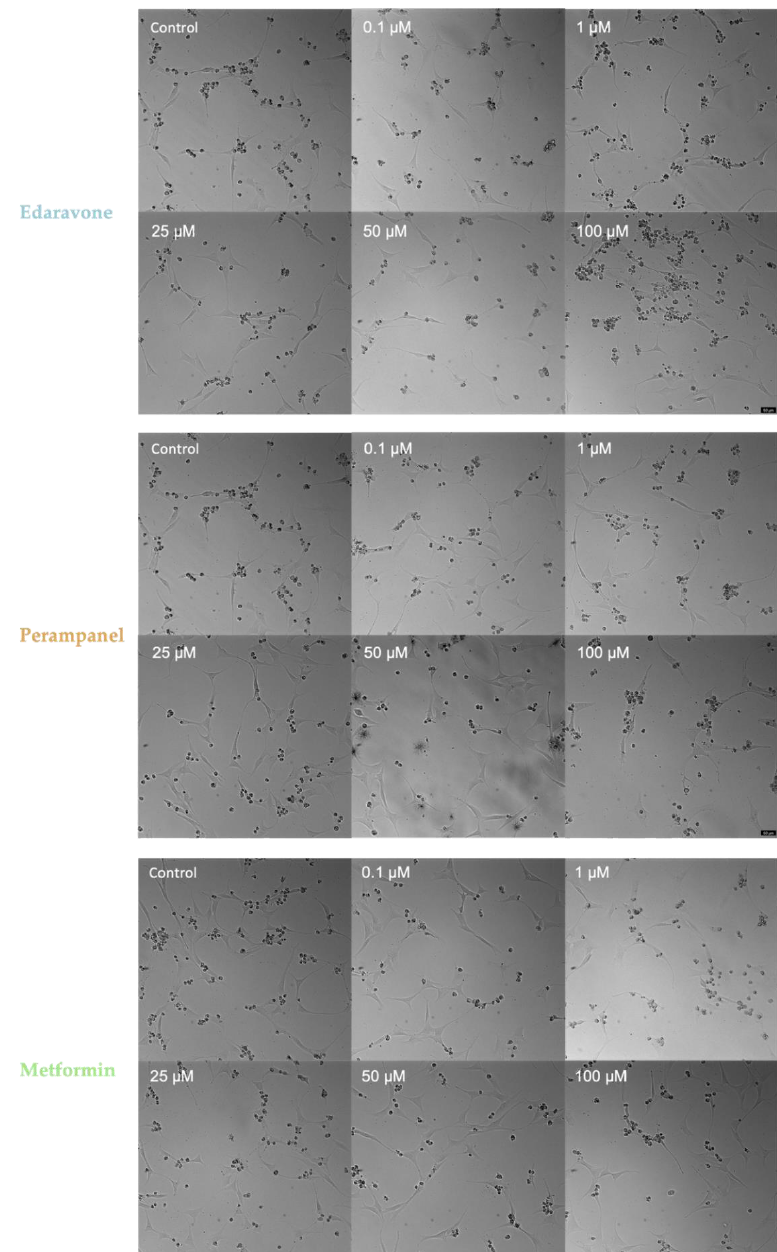
Figure 15. Microscopic representative images of HT-22 oxygen–glucose deprivation (OGD) control cells and HT-22 cells exposed for 48 h to OGD and concentrations, ranging from 0.1 to 100 µM, of edaravone, perampanel, and metformin. Images of cell morphology were obtained using a Leica microscope equipped with Leica LAS X imaging software v3.7.4 (Leica Microsystems, Wetzlar, Germany) from three independent experiments. Scale bar: 50 µm.